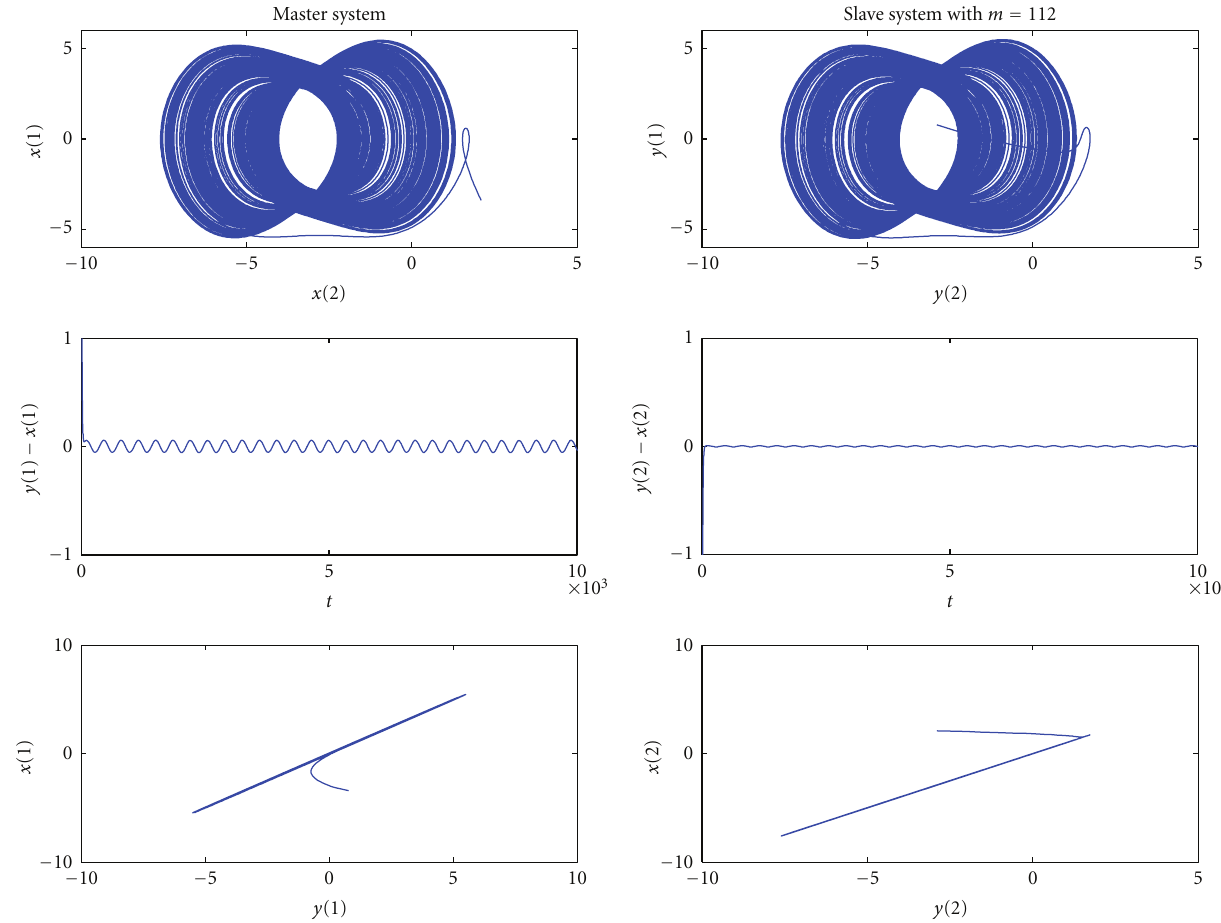
Figure 3: Phase portrait, errors, and similarity of unidirectional coupled systems with k = − 10 and m = 112